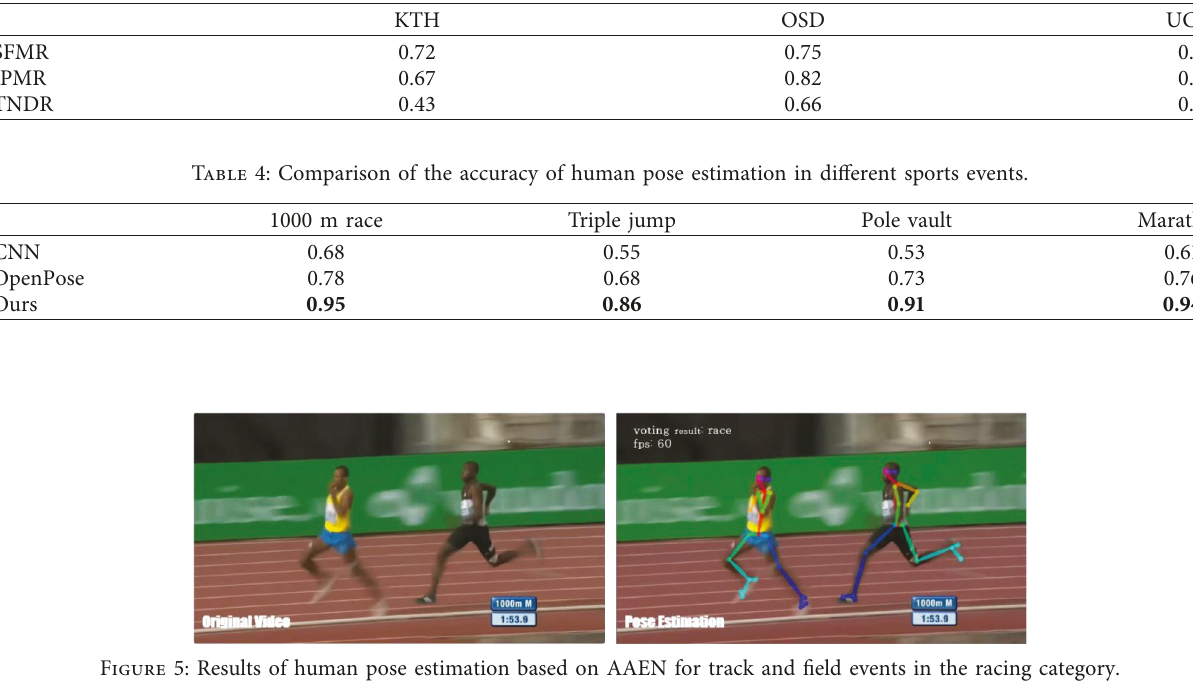
Table 3: Experimental results for different motion datasets.